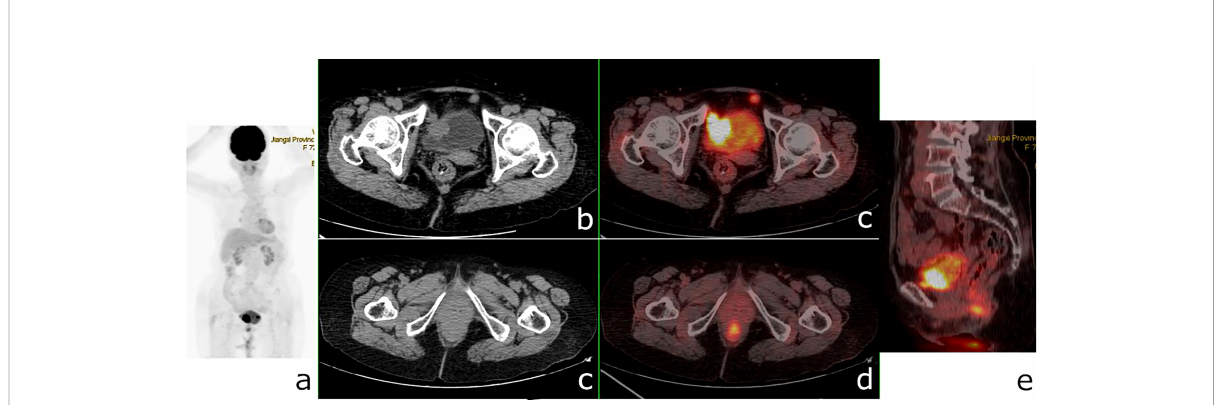
FIGURE 8 18 F- fl uorodeoxyglucose positron emission tomography/computed tomography ( 18 F-FDG PET/CT) of a 72-year-old woman with bladder cancer and anal canal adenocarcinoma. PET/CT revealed a 26 × 24-mm nodule in the bladder wall with a maximum standardized uptake value (SUV max ) of 23.9, a nodular hypermetabolic lesion (SUV max = 11.3) misinterpreted as physiological FDG uptake in the anal canal, and a small nodule with a diameter of 1 cm in front of the bladder (SUV max = 8.9). (A) PET/MIP. (B, C) Axial CT. (C, D) Fusion images. (E) Sagittal fusion